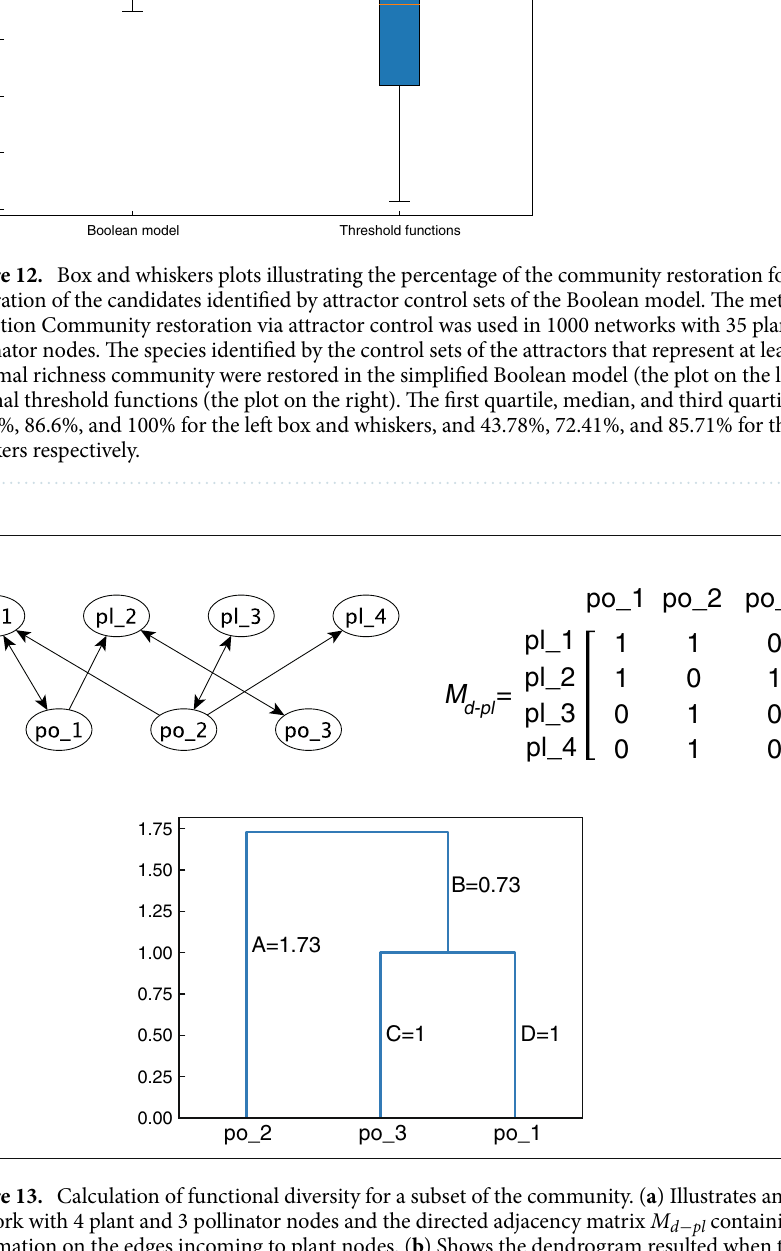
are available at https:// github. com/ Fatem ehFN/ consi stent_ groups_ of_ sms. To the best of our knowledge, it is the only python code that calculates of functional diversity for directed bipartite networks and suggests restoration strategies accordingly (Fig. 14).